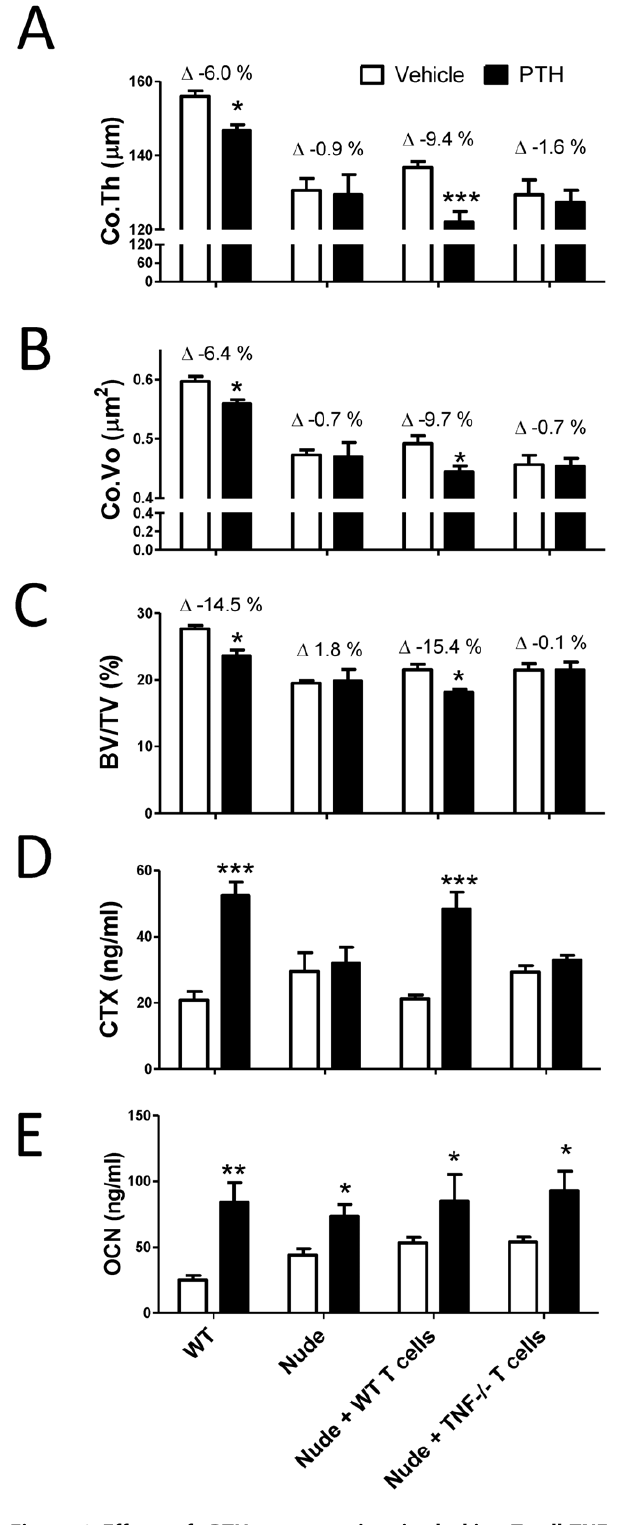
Figure 6. Effects of cPTH treatment in mice lacking T cell TNF production. A m CT analysis of femoral Co.Th. B m CT analysis of femoral Co.Vo. C m CT analysis of BV/TV. D Serum CTX levels. E Serum OCN levels. *=p , 0.05, **=p , 0.01 and ***=p , 0.001 compared to the corresponding vehicle treated group. n=10–17 mice per group. Data are Means + SEM.